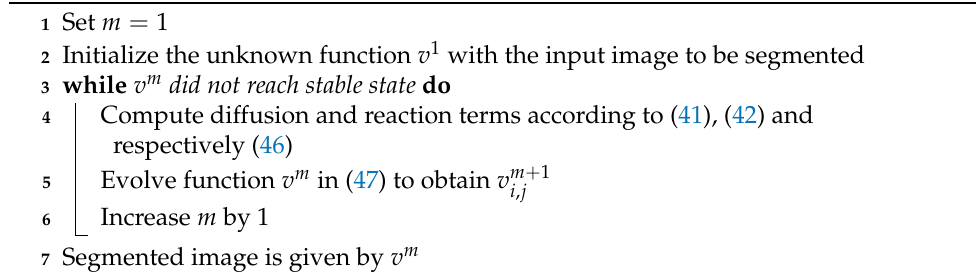
Algorithm 1: Reaction-diffusion based image segmentation algorithm